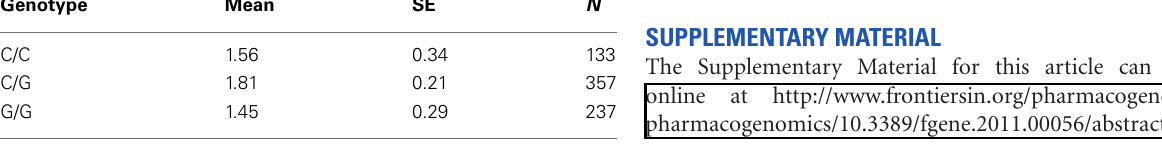
Table 8 |Adjusted mean weight gain in lbs for treatment and genotypes at rs11643744 ( FTO gene) in the interaction analyses. Treatment drug